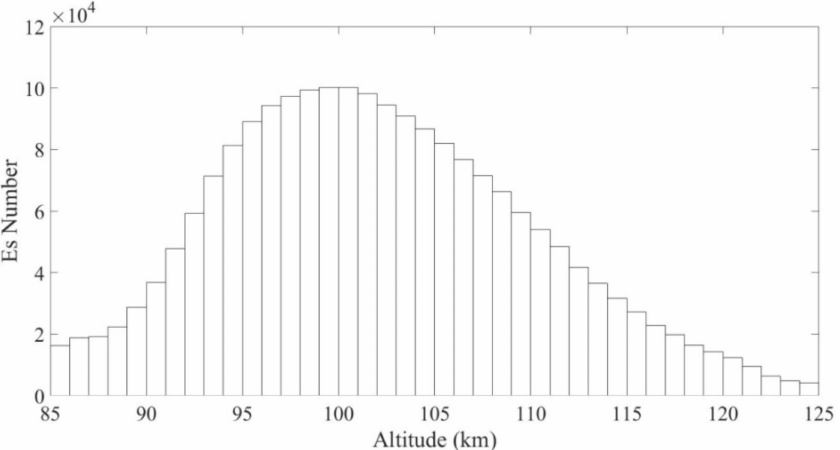
Figure 1. The altitude distribution of the Es layer derived from the COSMIC S4 index over the low latitudes during